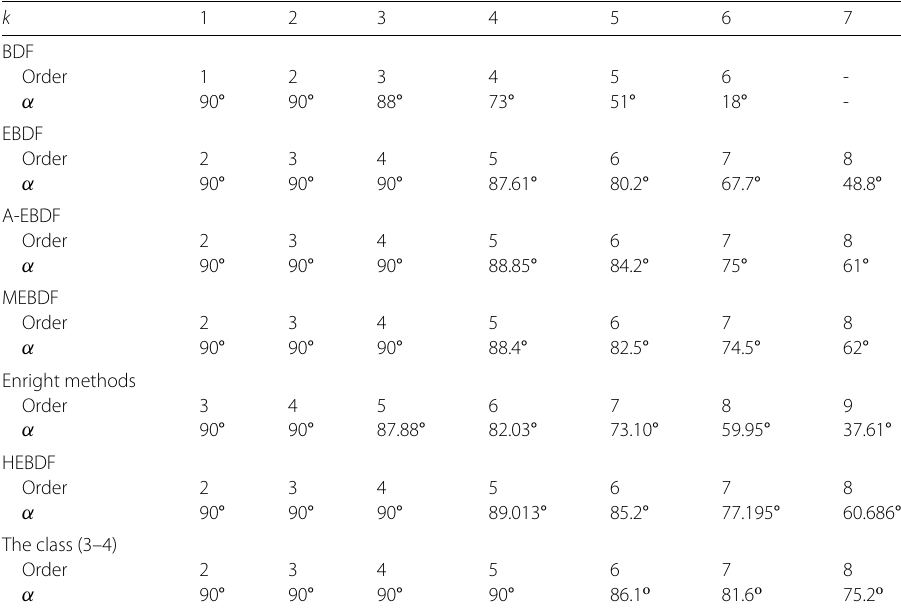
Table 5 A( α )-stability for BDF, EBDF, A-EBDF, MEBDF, Enright methods, HEBDF, and The class (3–4) for various orders